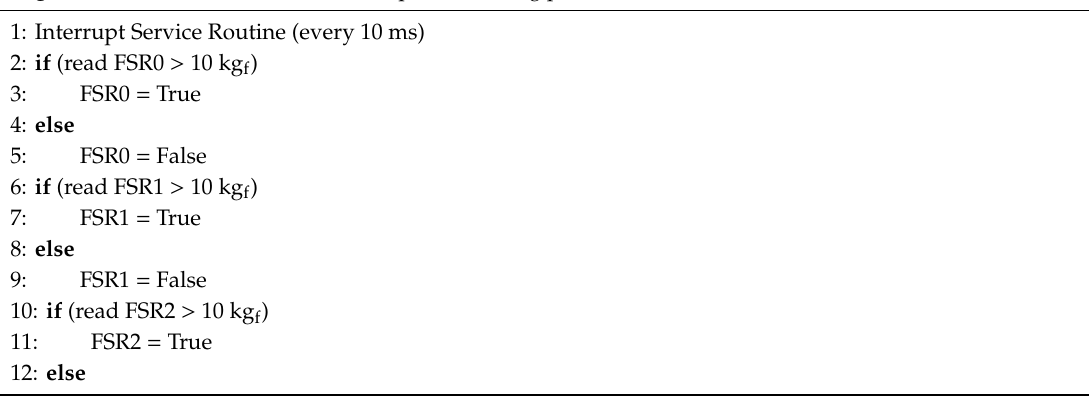
Algorithm A1 Pseudocode of four sub-phase labeling